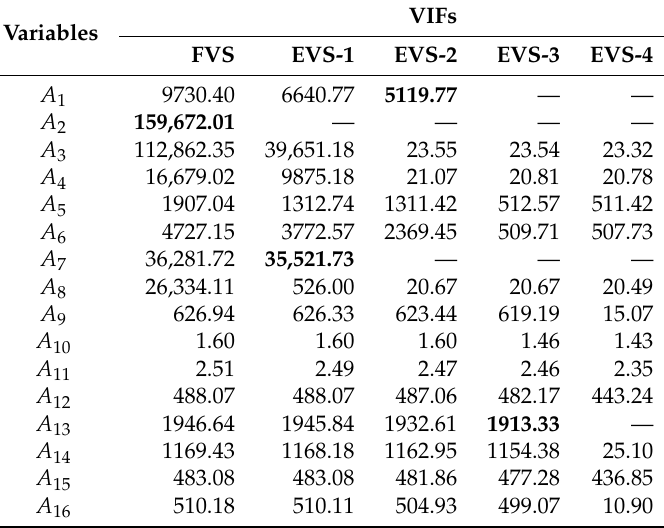
Table 3. Variance inflation factors (VIFs) in the north heading. FVS—full variable set; EVS—excluded variable